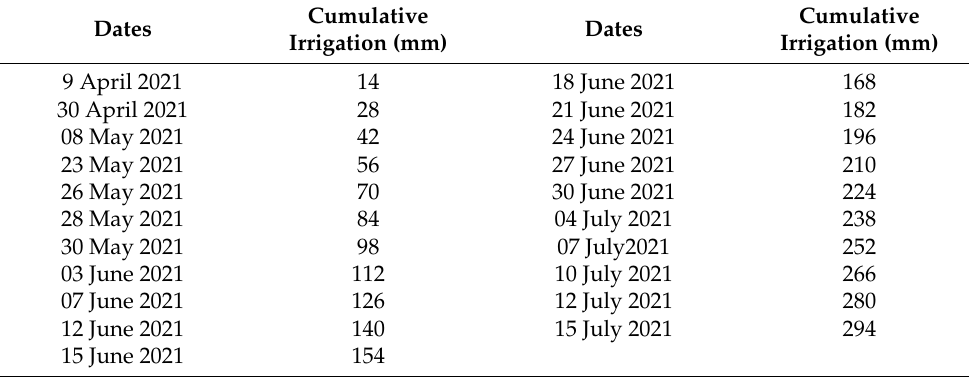
Table 2. Irrigation schedule and volumes.